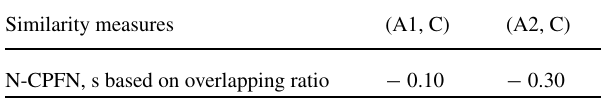
Table 1 Comparison of two software’s using proposed approach Similarity